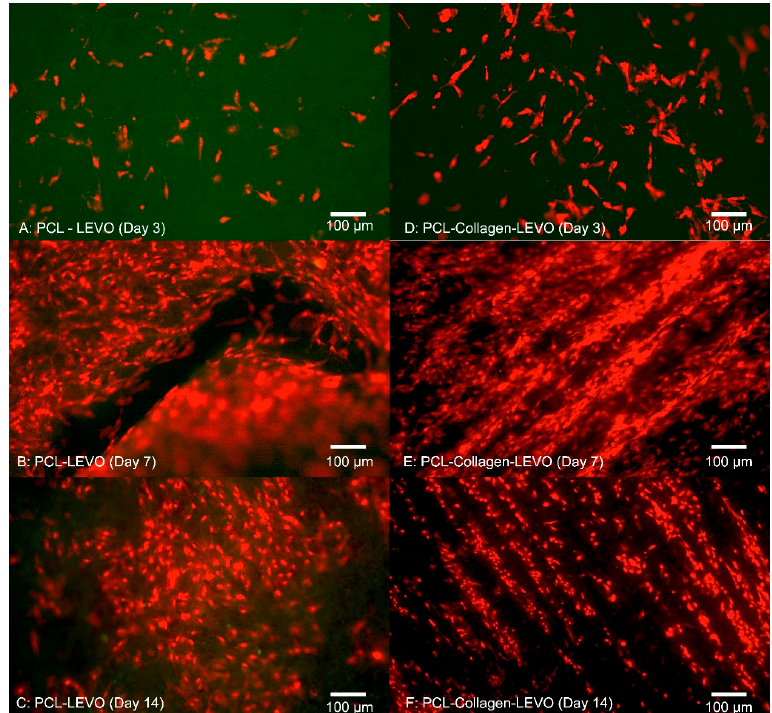
Figure 4. Fluorescent images of cell proliferation of RAOSMCs ( A ) PCL–LEVO after 3 days ( B ) PCL–